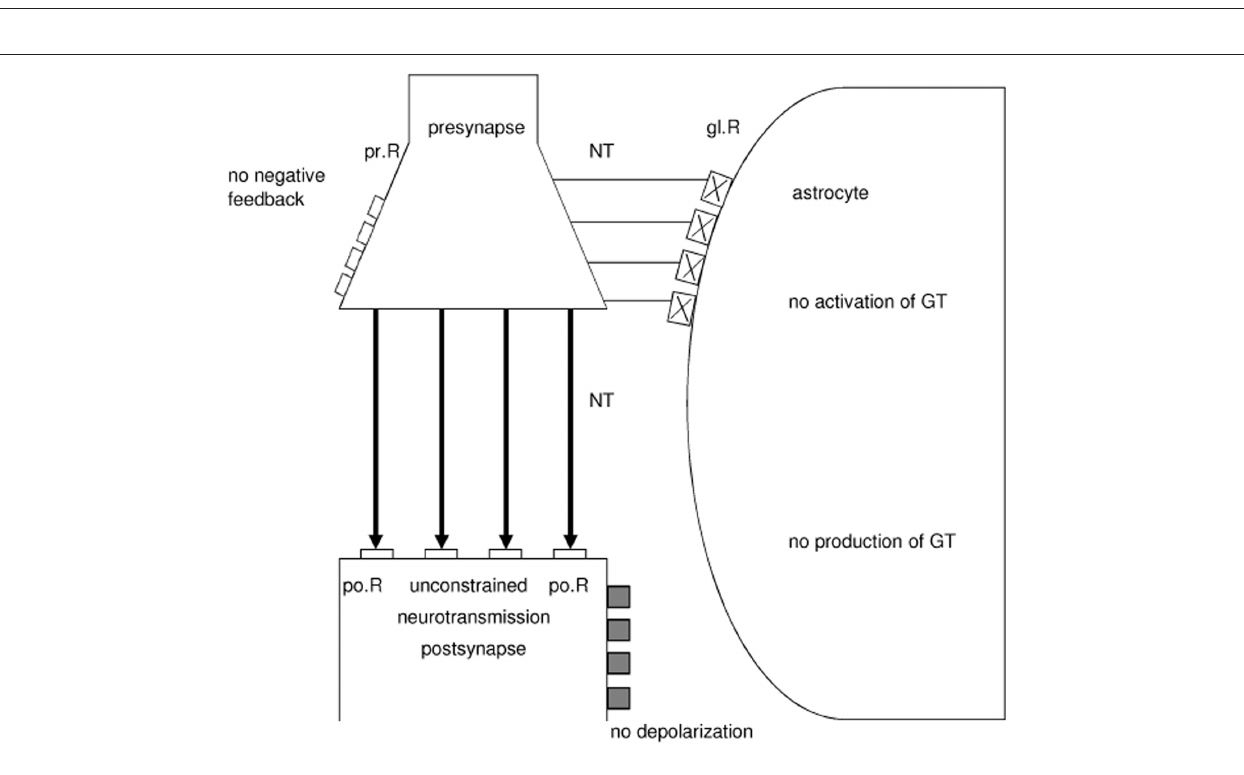
characterized with the category that its processes generate. From the left to the right examples of one to four processes (according to Table 1 ) are given. Blue colored processes connect axonic property 1, green property 2, yellow property 3, and brown property